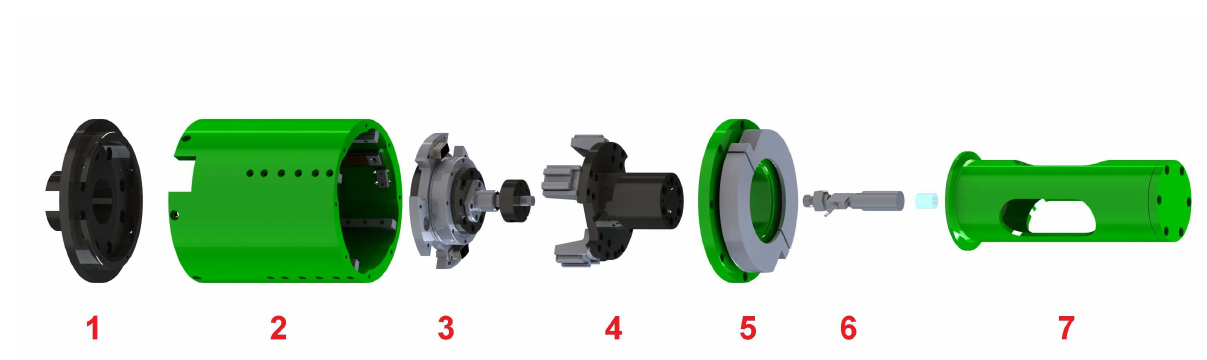
Figure 1. Visualization of the disassembled loading device with the main components: 1 - base plate (for rotary table), 2 - loading device frame, 3 - motor assembly with harmony gearbox, 4 - linear guide assembly, 5 - main body cover with clamps, 6 - loadcell and loading plate, 7 - loading chamber with loading